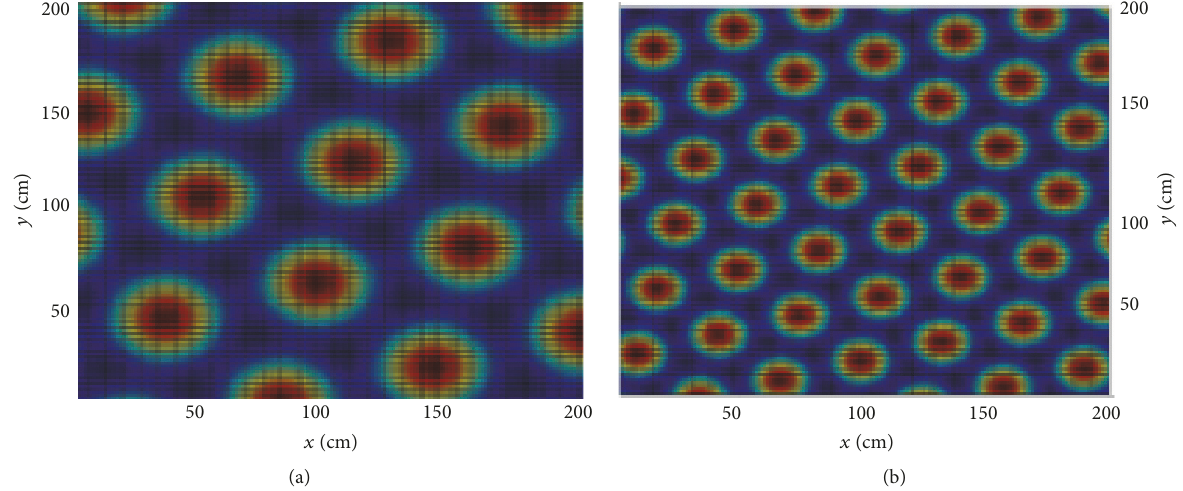
Figure 3: Examples of GCs with different grid spacing and field size activities (a) 𝑔 𝑛 (𝑥,𝑦) function with 𝜆 𝑛 = 1.6 m (coarse-scale grid) and (b) with 𝜆 𝑛 = 2.9 m (fine-scale grid). It is of note how the GCs build a coordinate map composed of multiple grid layers, each with a different length scale between grid points, but with fixed spacing between grid points for each 𝑛 th GC. By combining multiple-grained grid layers it is possible to enable an Euclidean coordinate map and identify point of